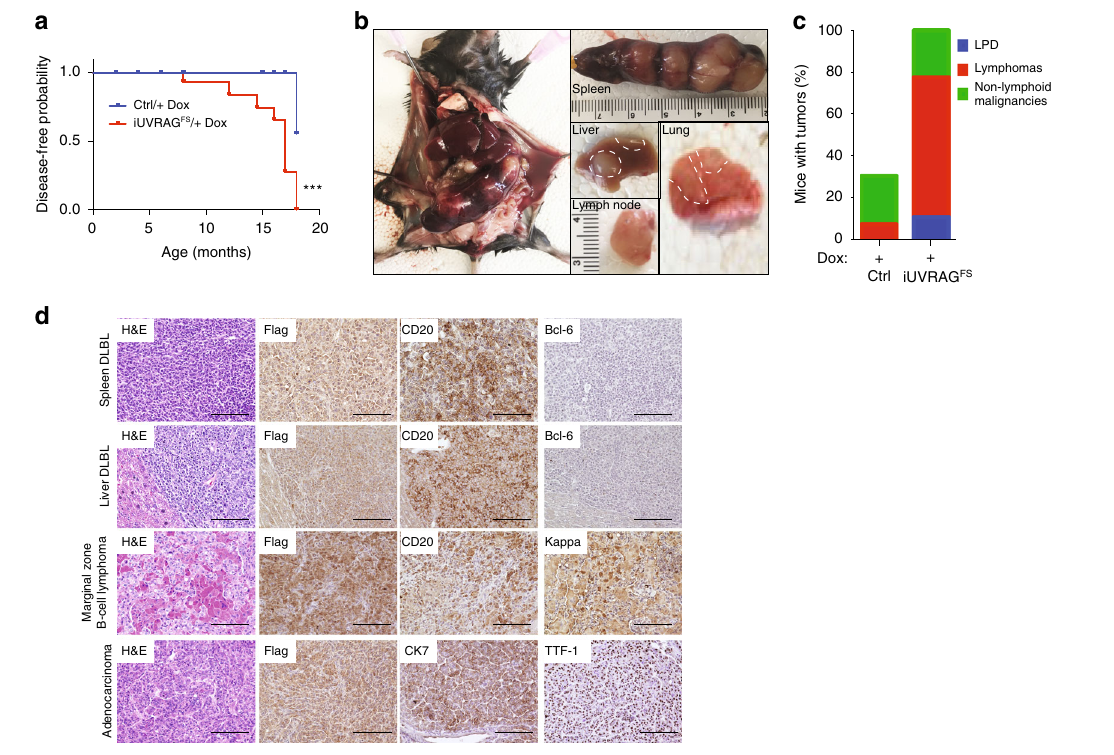
Fig. 6 UVRAG FS promotes spontaneous tumorigenesis in mice. a Kaplan – Meier plot of time to development of any malignancy in Dox-treated iUVRAG FS mice ( n = 25) versus Dox-treated control mice ( n = 25). Malignancy is determined by complete histologic survey of all major internal organs. *** P < 0.001 (Log-rank test). b Representative images of DLBCL in different organs that developed in Dox-treated iUVRAG FS mice. c Percentage of control ( n = 16) and UVRAG FS -expressing ( n = 12) mice with spontaneous tumors, including lymphoproliferative disease (LPD), lymphomas, and non-lymphoid malignancies. d H&E and IHC analysis of the most frequently observed neoplastic lesions from Dox-treated iUVRAG FS mice using the antibodies as indicated. Scale bars, 100 μ